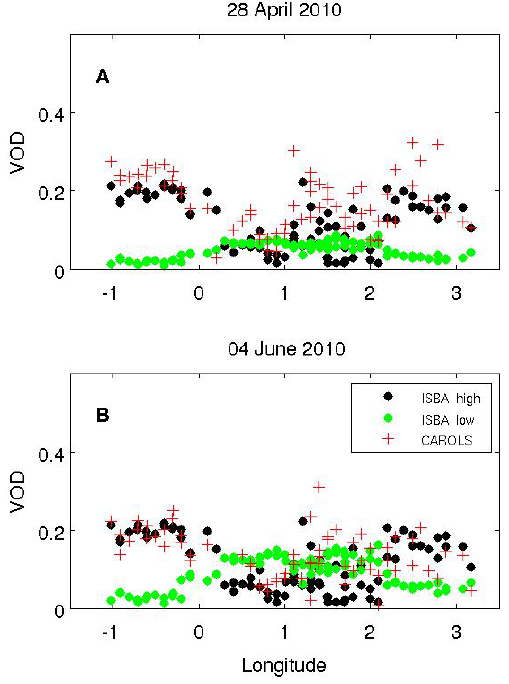
Fig. 9. Along-track variability of the CAROLS VOD and the VOD estimated using the ISBA-A-gs LAI of low vegetation, and the for- est fraction from ECOCLIMAP-II and b parameter=0.09 for low vegetation and 0.16 for high vegetation, for (A) 28 April 2010 and (B) 4 June